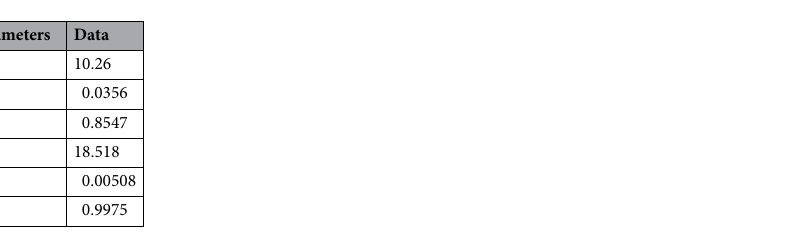
Table 2. Kinetic- model parameters for the adsorption of Pb(II) on UAS MIL53(Al).